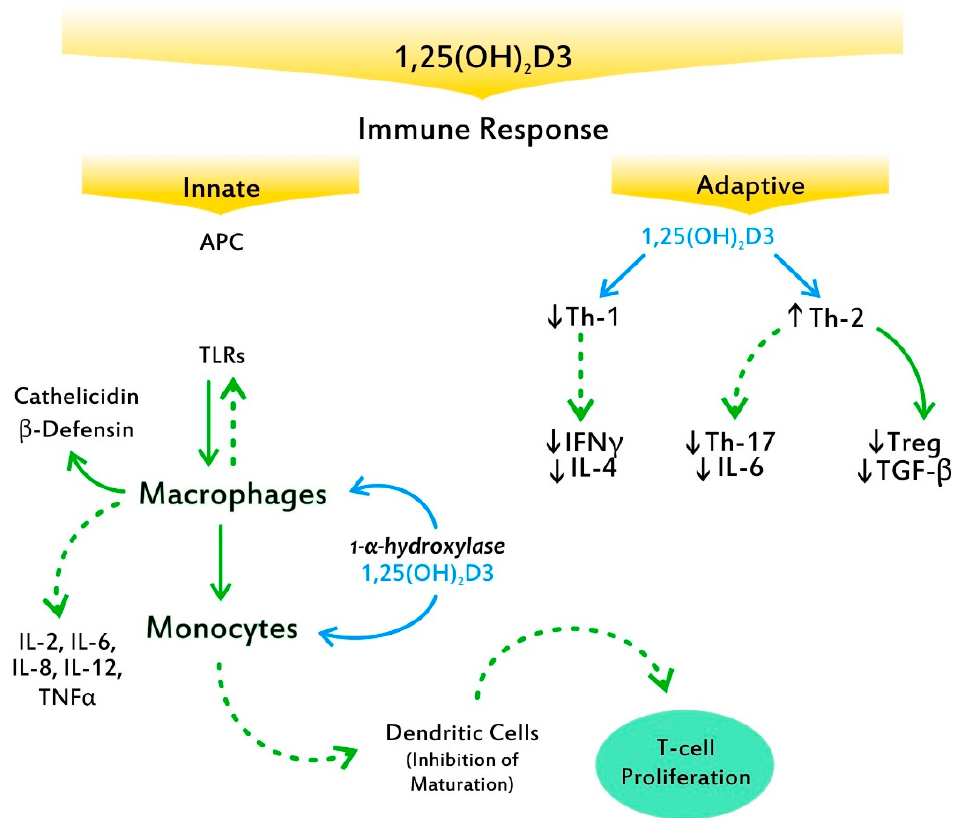
Figure 3. Toll-like receptors (TLRs) stimulated by antigens begin a cascade that results in the production by macrophages of peptides with potent bacterial activity such as cathelicidin and β - defensin. 1,25 (OH) 2 D3 generated by 1- α -hydroxylase in the monocyte and macrophage suppresses T cell proliferation via the induction of tolerogenic dendritic cells, resulting in a shift from a Type 1 T helper (Th1) phenotype to a Type 2 T helper (Th2) phenotype. Moreover, it affects T cell maturation with a skewing away from the inflammatory Th1-7 cytokine, while it facilitates the induction of anti-inflammatory T regulatory cells (Tregs). Solid arrows indicate a positive effect. Dotted arrows indicate an inhibitory effect.